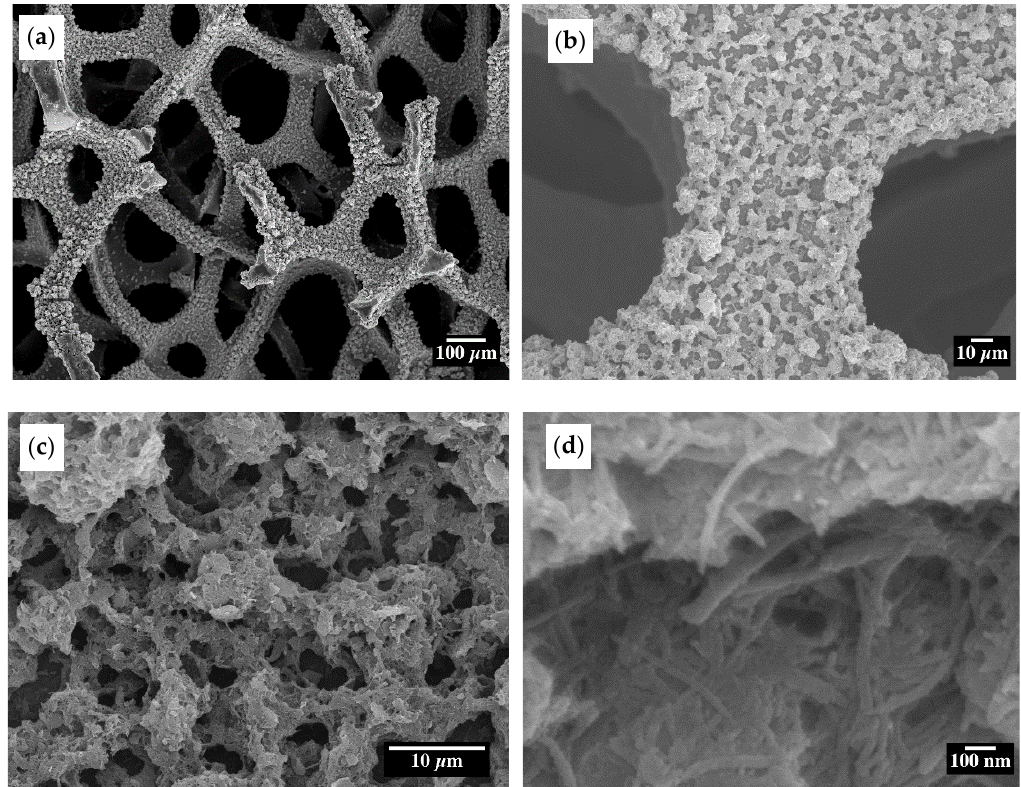
Figure 3. SEM images of the confined SnO 2 in a CNT at different magnifications ( a – c ) uniform porous morphology, and ( d ) dispersed CNT.